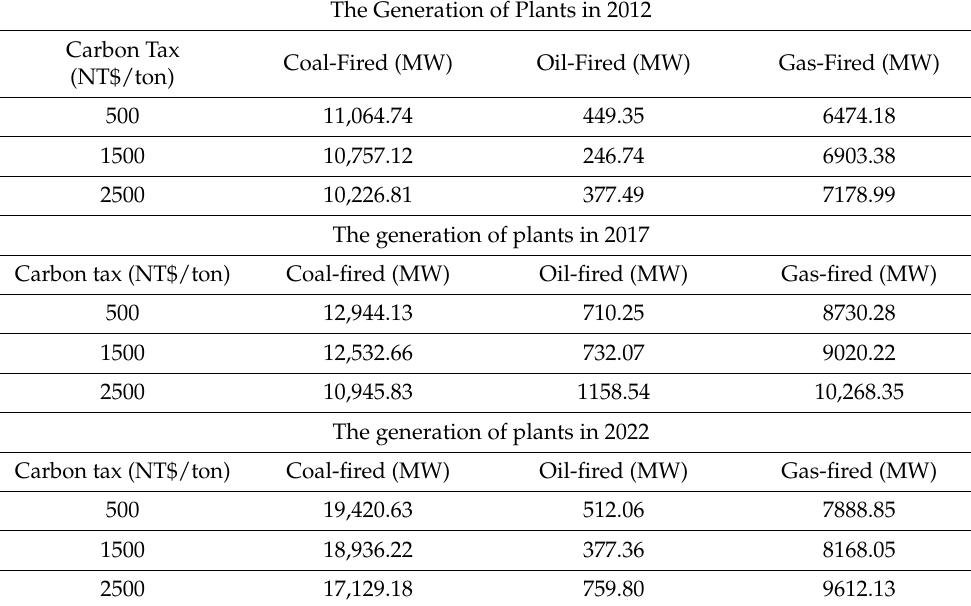
Figure 2. The relationship between emissions and time in the analysis of Case 1. Table 4. The generation of plants among the various fossil-fired plants in case